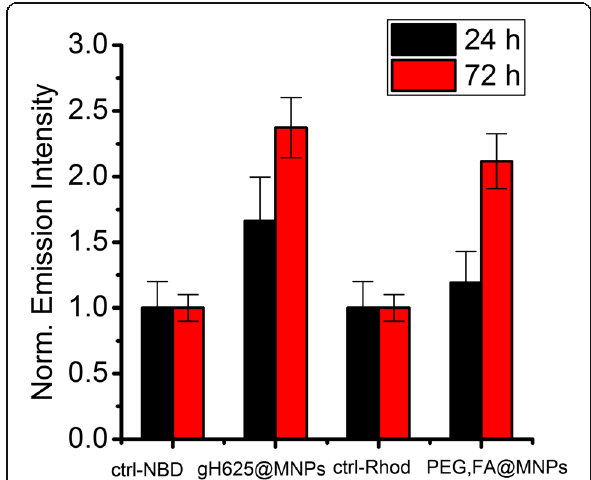
Fig. 8 Normalized intensities of intracellular fluorescence. Quantitative analysis of intracellular fluorescence after HBMEC incubation at 24 and 72 h with NBD-labeled gH625@MNPs and Rhod-labeled FA,PEG@MNPs